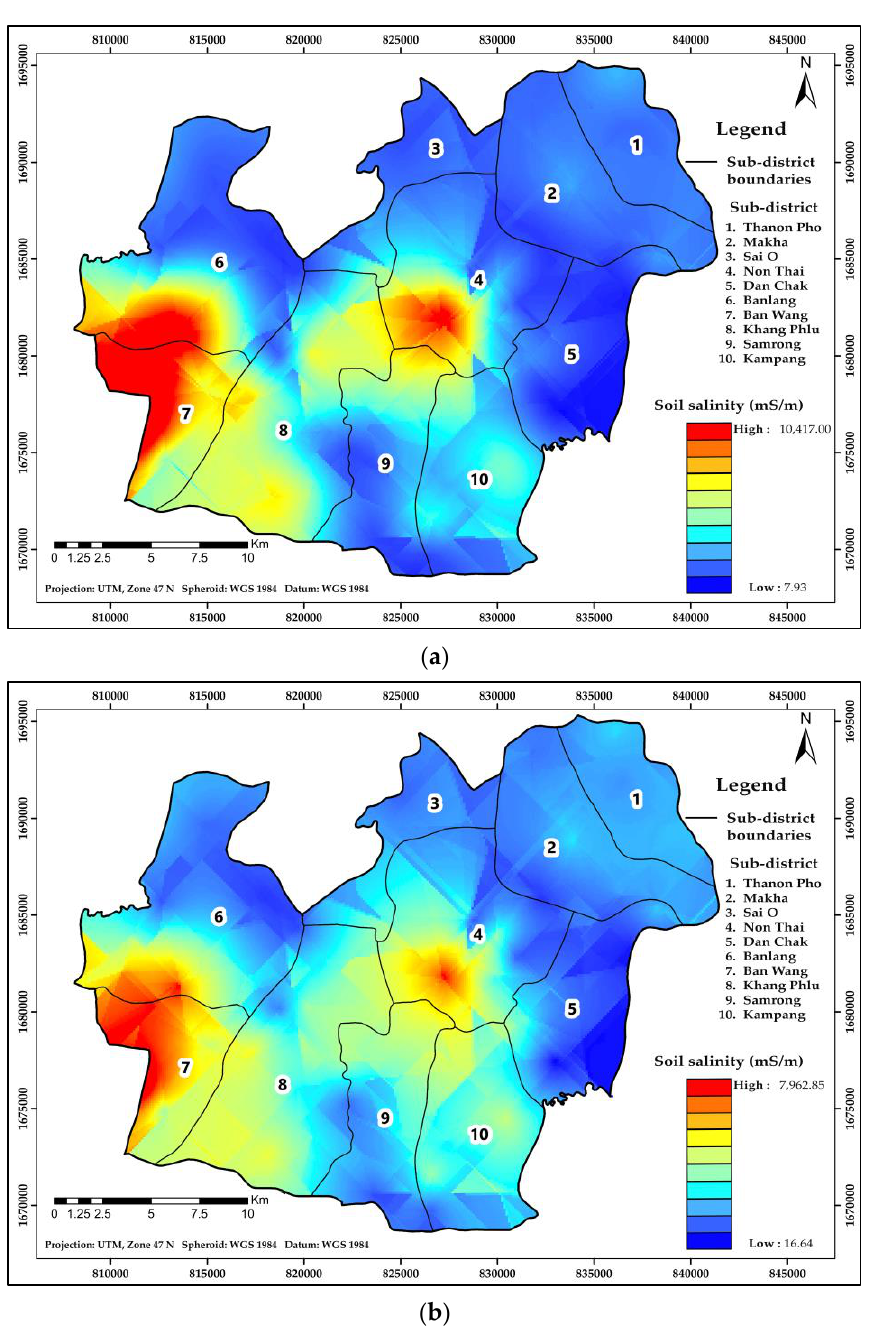
Figure 10. Spatial distribution of soil salinity prediction using OK of two modes: ( a ) HH and ( b ) VV.